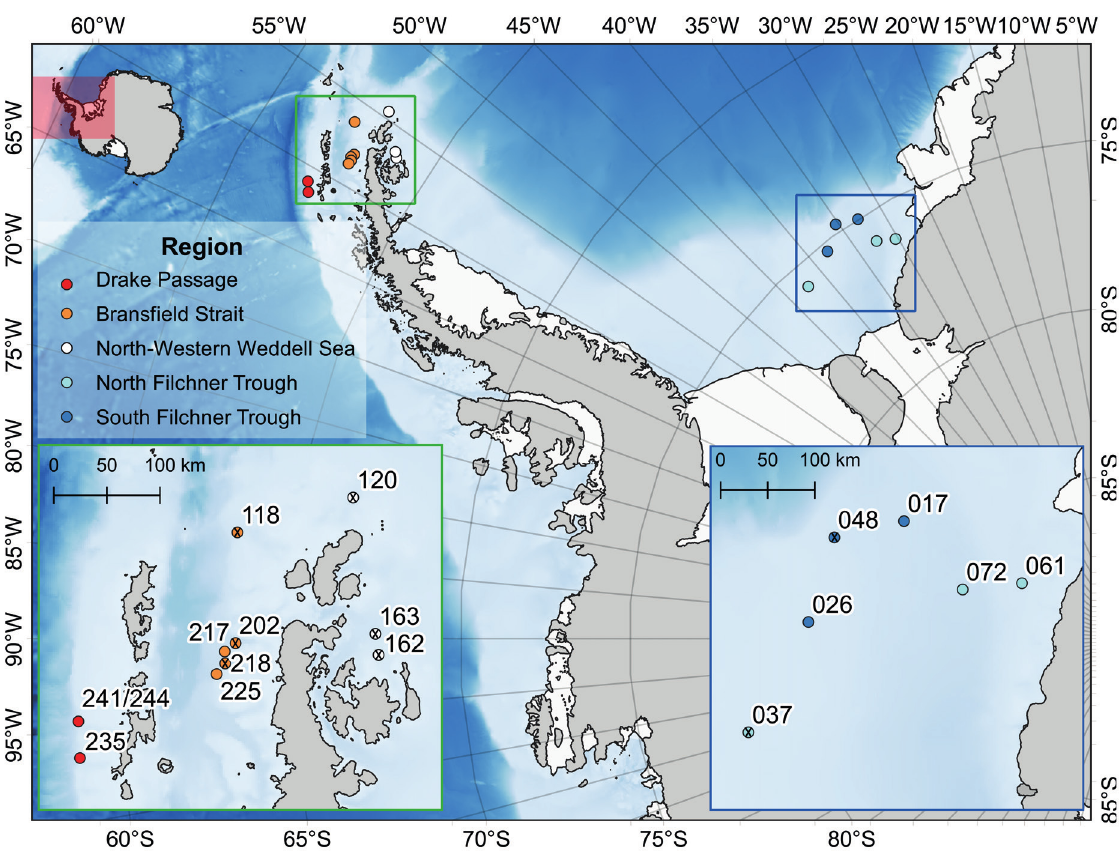
Fig. 2. Sampling stations in the vicinity of the Antarctic Peninsula during RV Polarstern expedition PS 81 (Drake Passage, Bransfield Strait, North-Western Weddell Sea, green frame) and the South-Eastern Weddell Sea during PS 96 (North Filchner Trough, South Filchner Trough, blue frame). Stations without Anobothrus konstantini Säring & Bick sp. nov. labeled with a cross. Information about sampled stations and number of individuals of A. konstantini Säring & Bick sp. nov. are given in Table